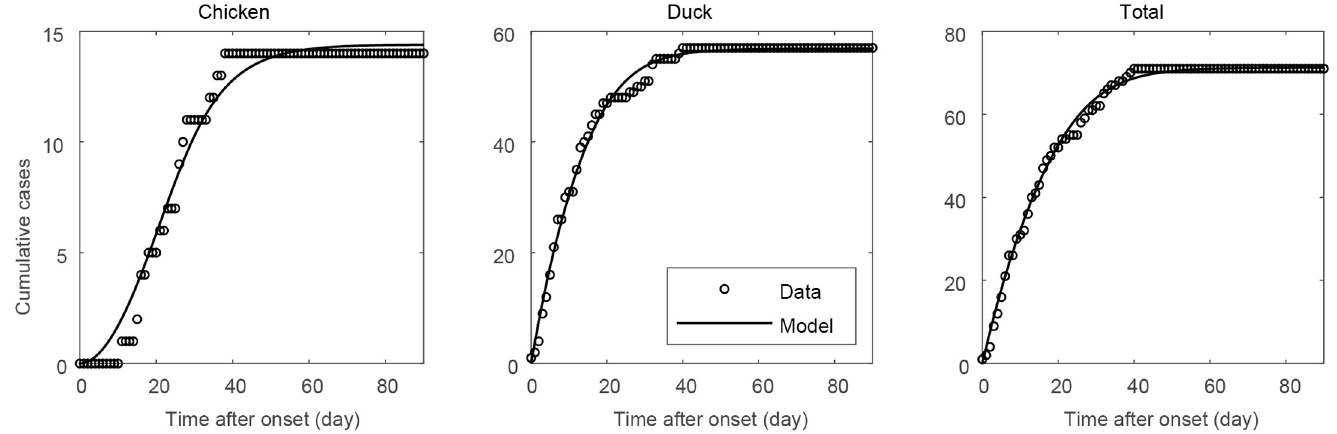
Fig 3. In each panel, circles represent the AI-reported farm data and black solid curves represent the corresponding simulation results.